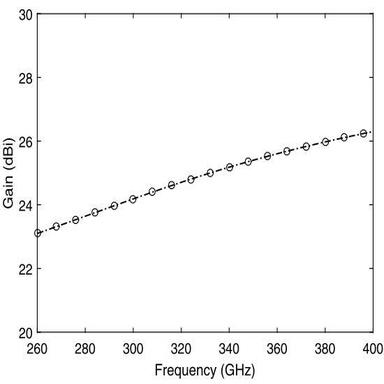
Antenna gain 260 GHz to 400 GHz range.